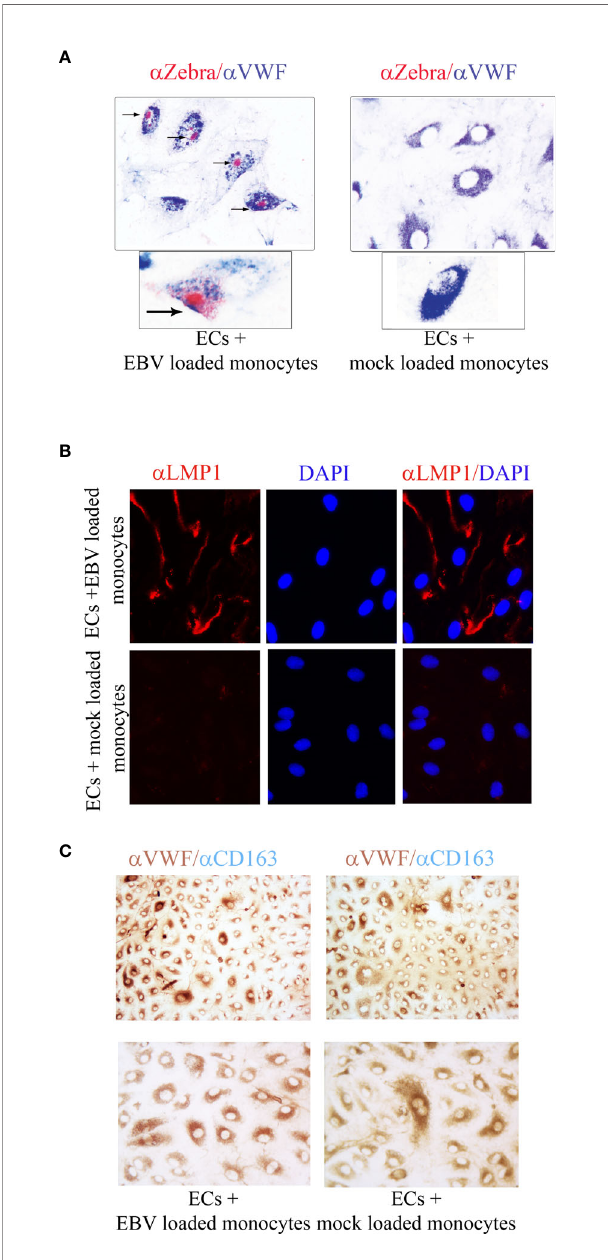
FIGURE 6 | ZTA/EBV lytic and LMP1/EBV antigens are expressed in human dermal microvascular endothelial cells infected with EBVp2089. EBV/p2089 loaded monocytes were co-cultured with endothelial cells. After 48 hrs monocytes and free cell EBV-p2089 were removed. (A) Dual immunocytochemistry (ICC) staining showing Von Willebrand Factor (VWF) antigen in the cytoplasm and Zta protein in the nuclei of a subset of infected endothelial cells. Original magni fi cation 400x, box area: original magni fi cation 1000x. (B) Immuno fl uorescence of endothelial cells stained with LMP1/EBV latent antigen (red) as indicated. Diaminidino-2-phenylindole (DAPI) was used as counterstaining for the nuclei. Original magni fi cation 400x. (C) Dual ICC staining showing positive cells for Von Willebrand Factor (VWF) antigen in the cytoplasm (brown) and negative for CD163 mononcyte surface antigen (blue). Upper image Original magni fi cation 100x, lower image original magni fi cation 400x. Representative of 5